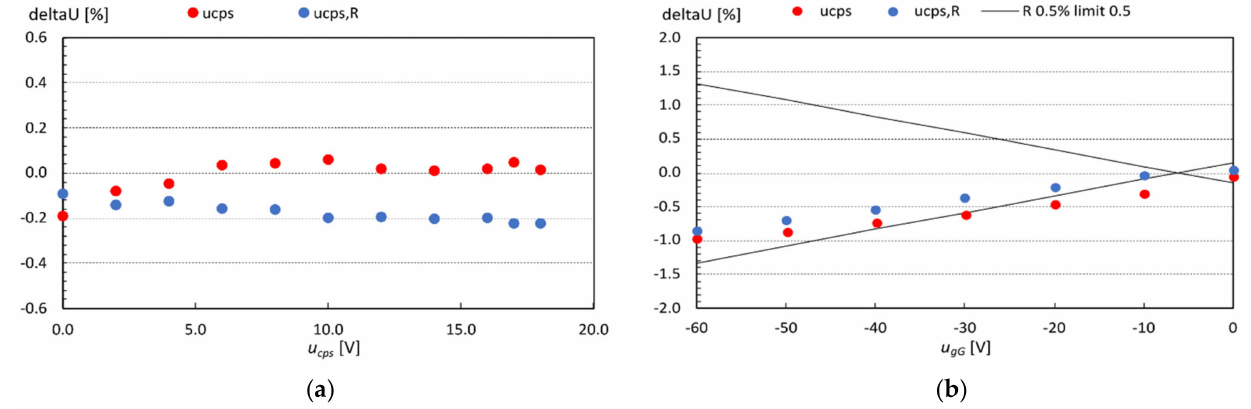
Figure 18. Voltage error for u cps measurement: ( a ) for the nominal range from 0 V to u cps = 18.0 V; ( b ) for u cps = 18.0 V vs. u gG